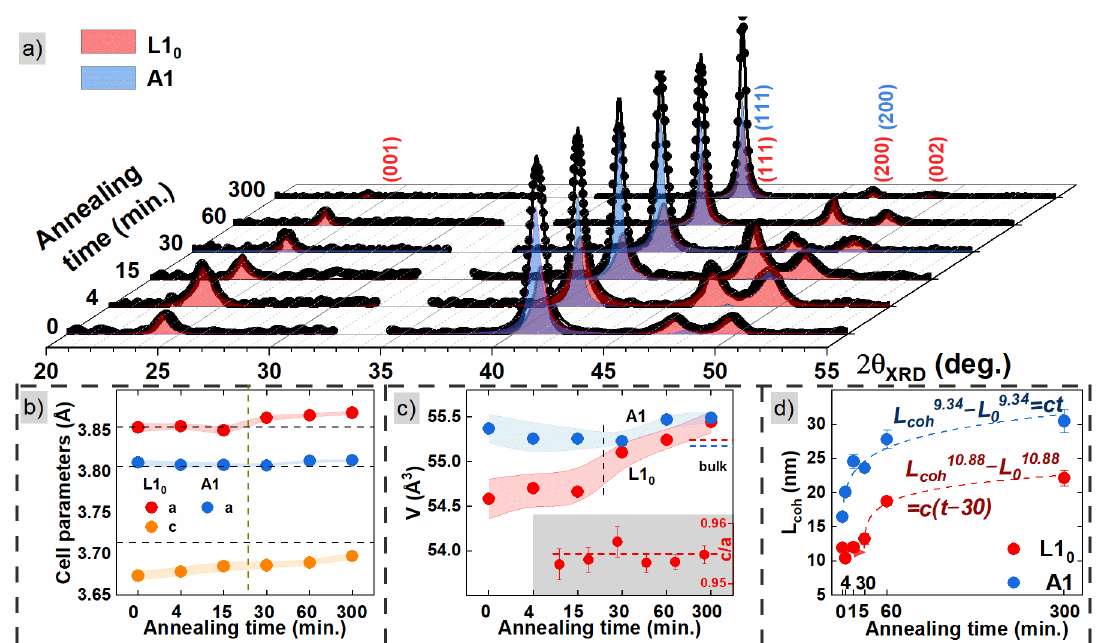
Figure 1. ( a ) Diffractograms of FePd thin alloy films after different times of annealing. The blue and red colors correspond to the A1 phase and the L1 0 phase, respectively. The parameters extracted from the XRD patterns are presented below: ( b ) cell parameters, ( c ) cell volume, and ( d ) coherence length. The inset of figure ( c ) shows the tetragonal distortion ratio